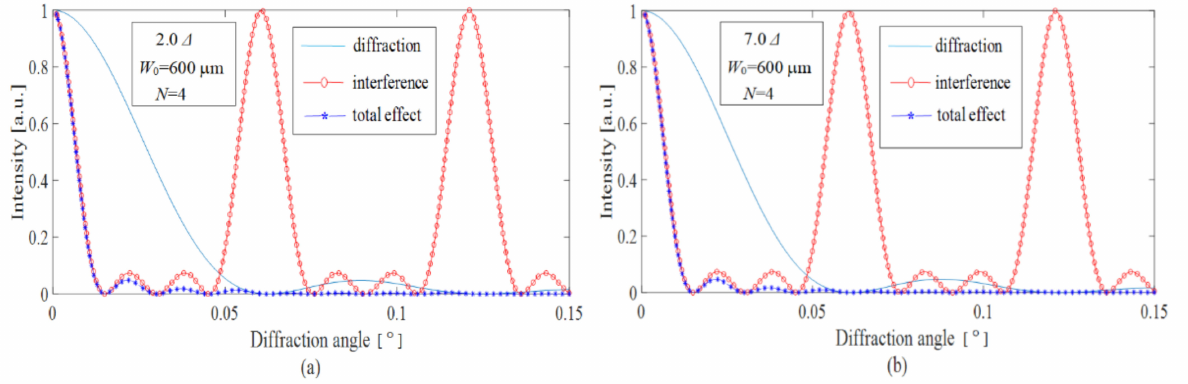
Figure 4. Diffraction, interference, and total effect for the microprism with W 0 = 600 µ m, and with 2.0 ∆ for ( a ) and 7.0 ∆ for ( b ).